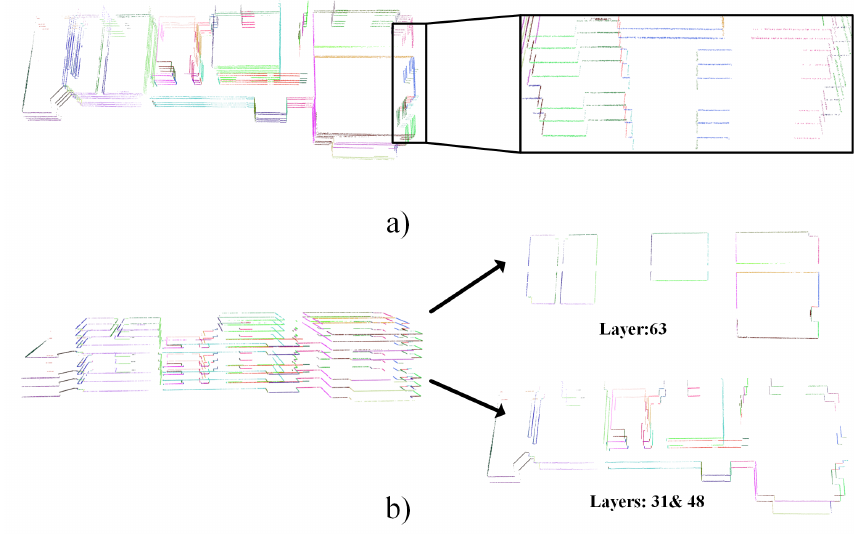
Figure 11. The multi-view of representative layers (top-down view and side-view): ( a ) Enlarged bay window structure, and ( b ) selected layers retain different building